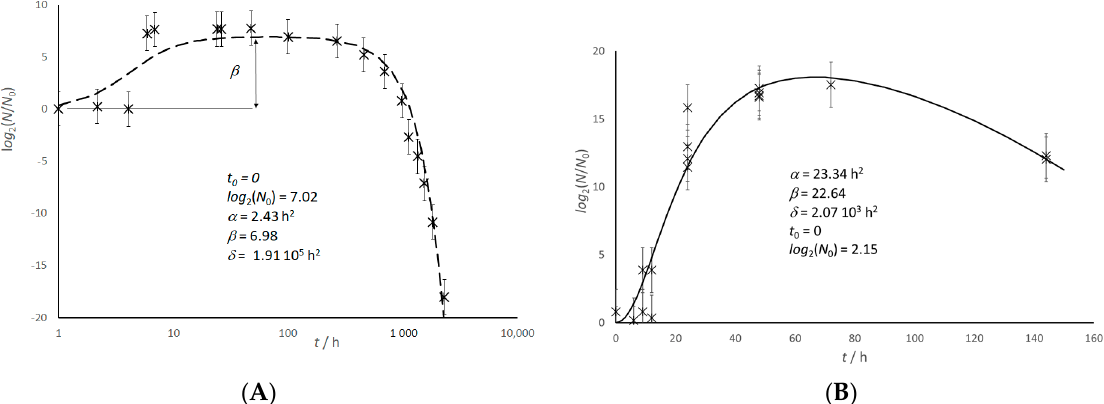
Figure 7. Escherichia coli : the same data as in Figure 6 ( A ) and Listeria monocytogenes in milkshakes ( B ) after [15], fitted with Equation (13). The relevant parameters (insert) come from the best-fit routine. Bars correspond to the standard error. Time is in a log 10 scale.